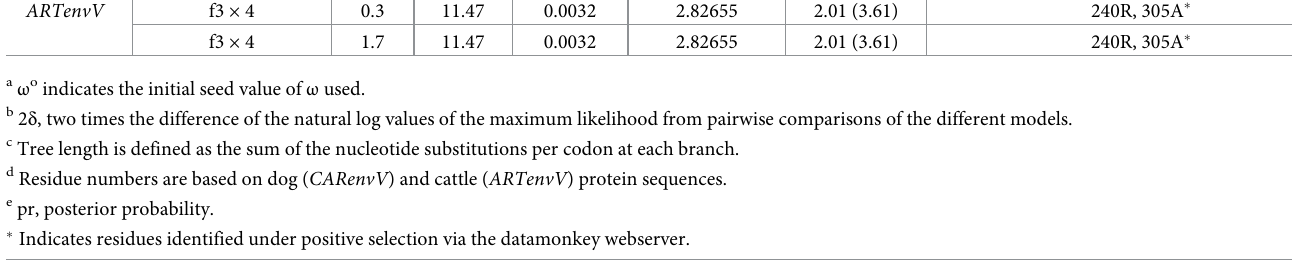
positive selection with a posterior probability of > 0.95 (Table 1) although no sites mapped to homologous sites in the two lineages. Three of these residues for CARenvV and one for ARTenvV were also found to be under positive selection by the MEME and FEL programs in the Datamonkey webserver [73]. At most sites, however,orthologs of both CARenvV and ARTenvV showed high sequence similarity, with pairwise ω values much below unity for the vast majority of the species (S5 and S6 Files). These results indicate that while both ARTenvV and CARenvV are highly conserved, they have each been subject to recurrent positive selection in their respective orders.